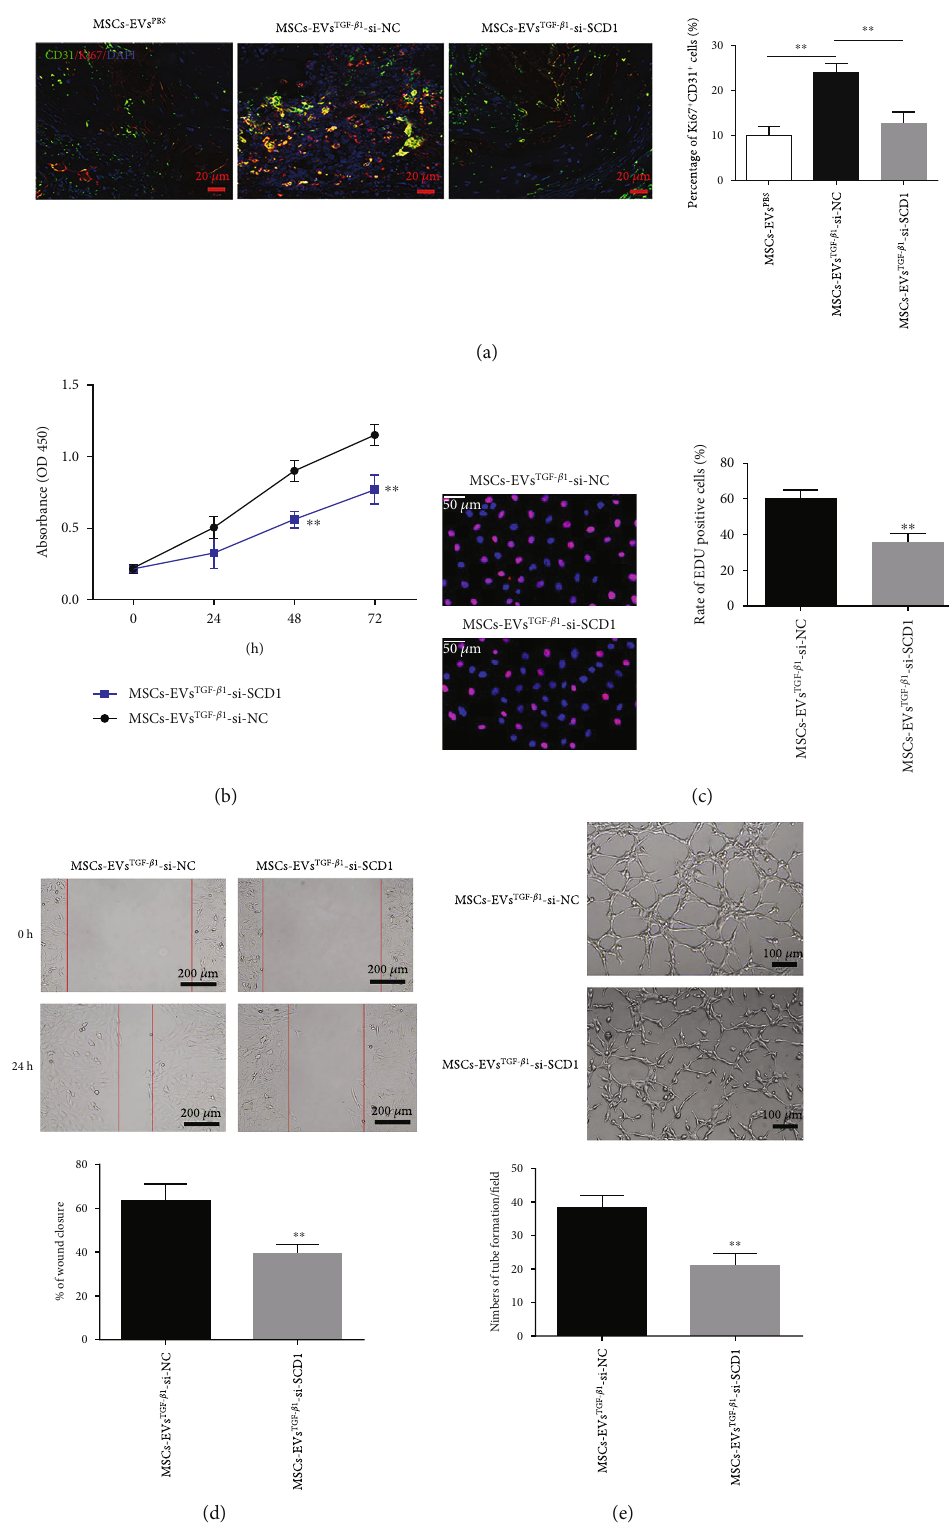
Figure 6: SCD1 knockdown reduces MSC TGF- β 1 -EV-stimulated proliferation, angiogenesis, and migration in vivo and in vitro . (a) Immuno fl uorescence staining of Ki-67 (red) and CD31 (green) in callus tissues from mice administered with MSC PBS -EVs, MSC TGF- β 1 - EV-si-NC, or MSC TGF- β 1 -EV-si-SCD1 on day 21 postfracture. Quanti fi cation of positive Ki67/CD31 cells, n = 3 . (b – e) The functional e ff ects of MSC TGF- β 1 -EV-si-SCD1 on proliferation, migration, and angiogenesis as measured by CCK-8, EdU, wound healing assays, and tube formation, n = 3 . Data are expressed as mean ± SD ; ∗∗ P < 0 : 01 . MSCs: mesenchymal stem cells; EVs: extracellular